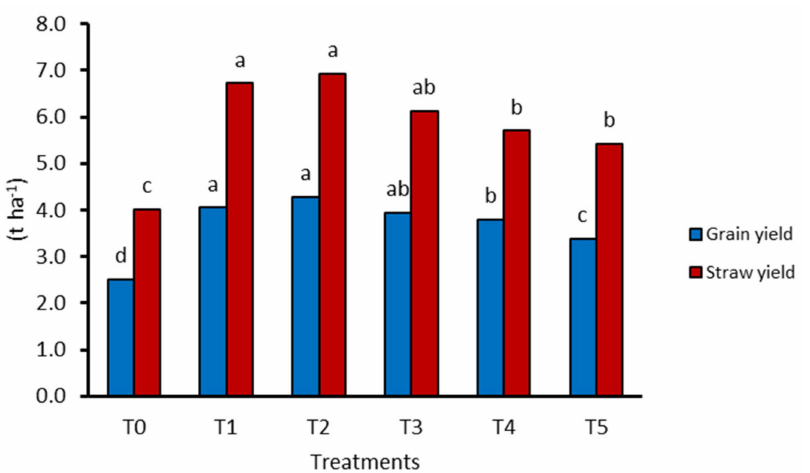
Figure 5. Effect of treatments on grain yield and straw yield of BRRI dhan28 (bars having the same letter(s) are statistically similar, and those having dissimilar letter(s) differ significantly at 0.05 level of probability: T 0 , control; T 1 , mineral fertilizers only (STB); T 2 , vermicompost (10 t ha − 1 ) (IPNS) + mineral fertilizer; T 3 , cow dung (10 t ha − 1 ) (IPNS) + mineral fertilizer; T 4 ,